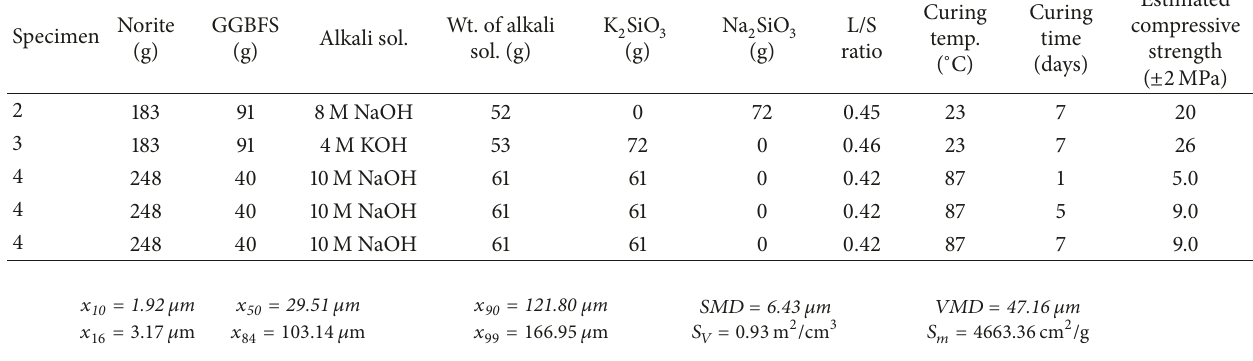
Table 5: Influence of GGBFS on the compressive strength of the binder. The specimens were cured at ambient pressure. Norite Specimen (g)